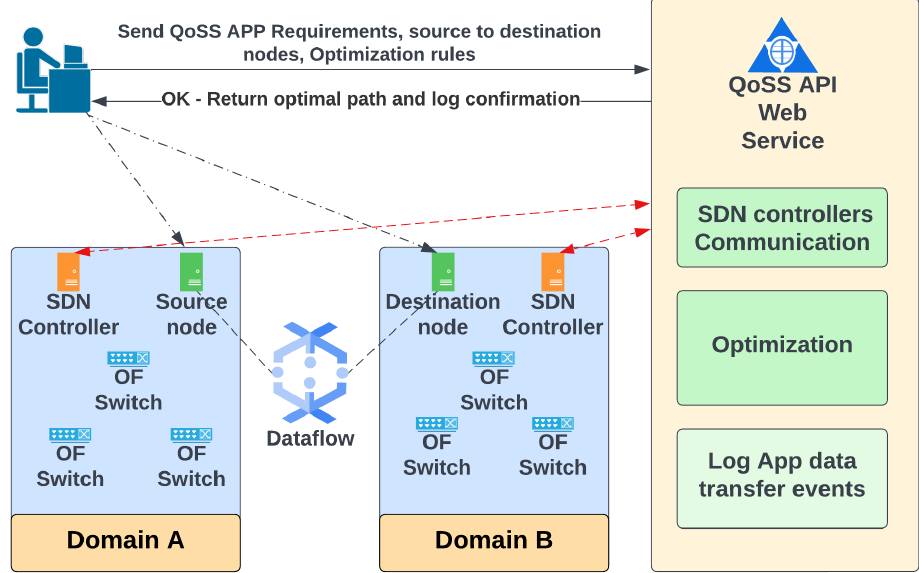
Figure 1. QoSS API Web Service general